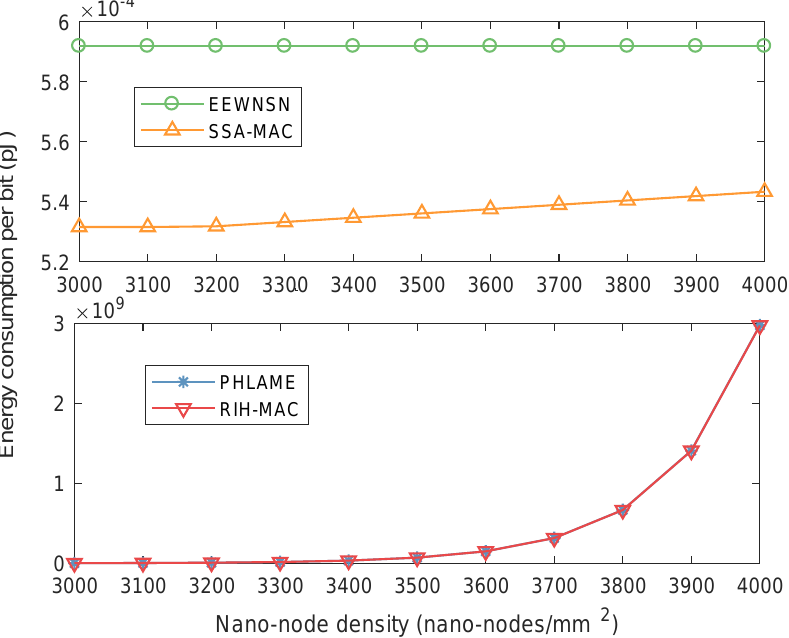
Figure 8. Energy consumption per bit of different MAC protocols with much higher nano-node density in centralized